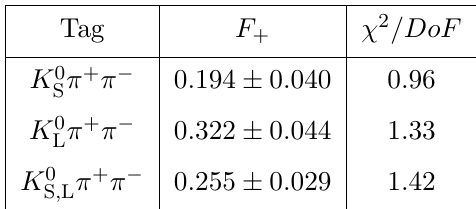
(cid:25) + (cid:25) (cid:0) and K 0 (cid:25) + (cid:25) (cid:0) . The row S L